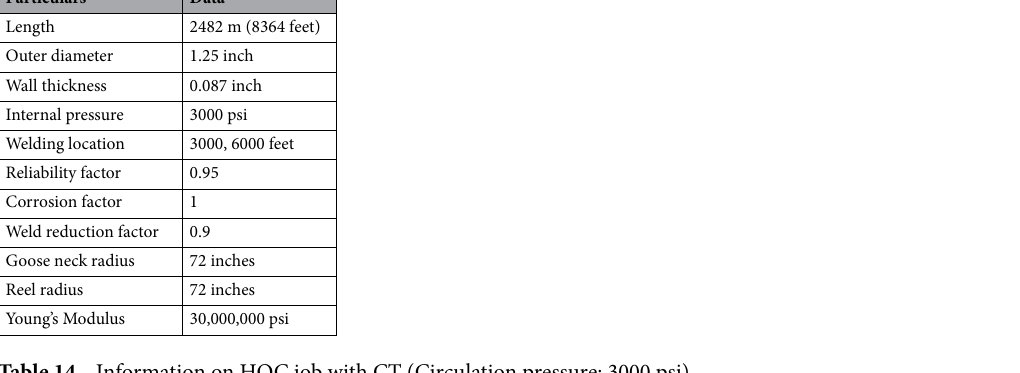
Table 14. Information on HOC job with CT (Circulation pressure: 3000 psi).